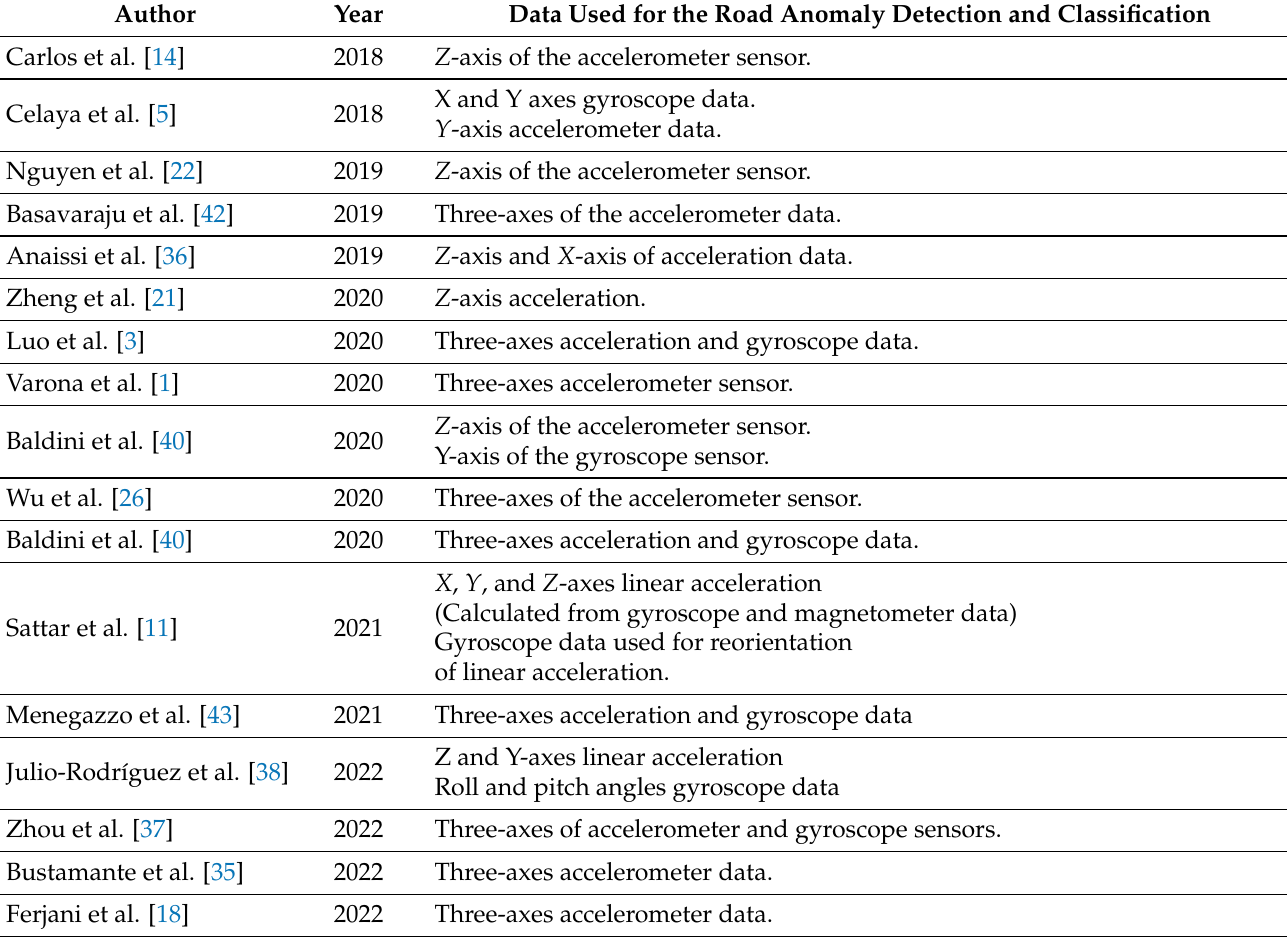
Table 6. Summary of the type of signals used for road surface anomaly detection and classification through vibration-based